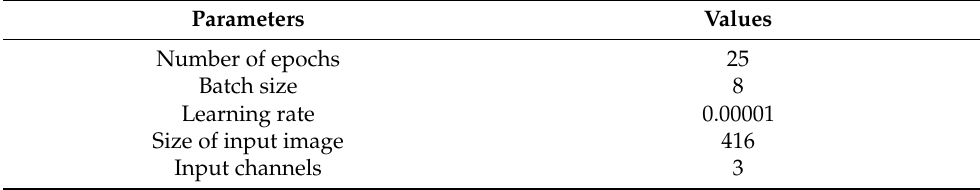
Table 4. Last training parameters of the car object detection model.